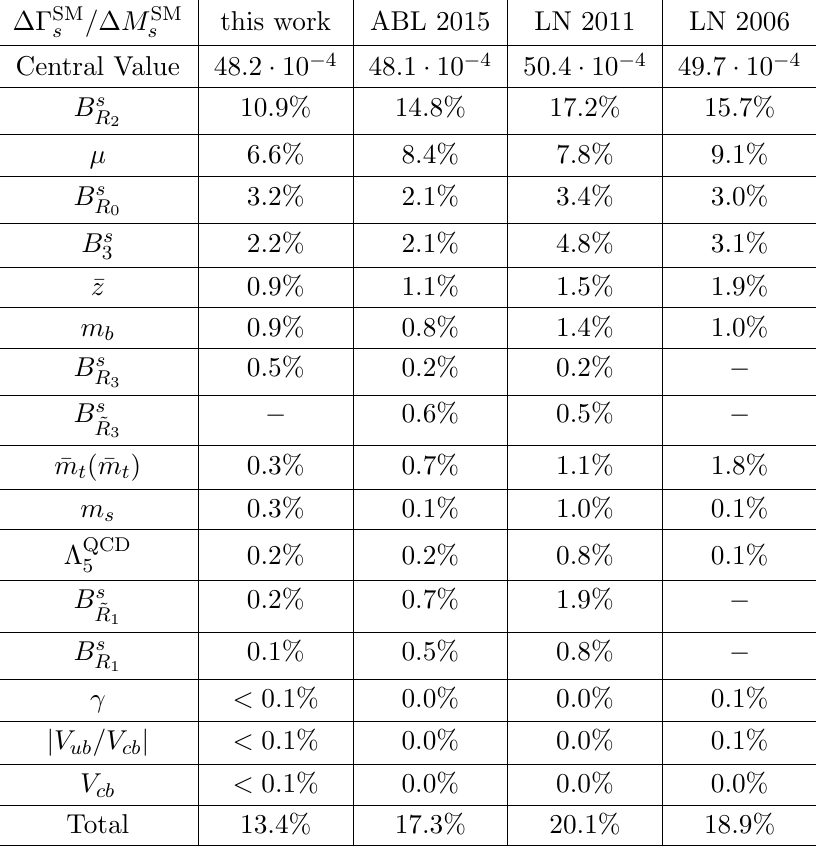
Table 10 . List of the individual contributions to the theoretical error of the ratio (cid:1)(cid:0) s /(cid:1) M s within the Standard Model and comparison with the values obtained in 2015 [31], in 2011 [128] and in 2006 [87]. We have used equations of motion in the current analysis to get rid of the operator ~ R 3